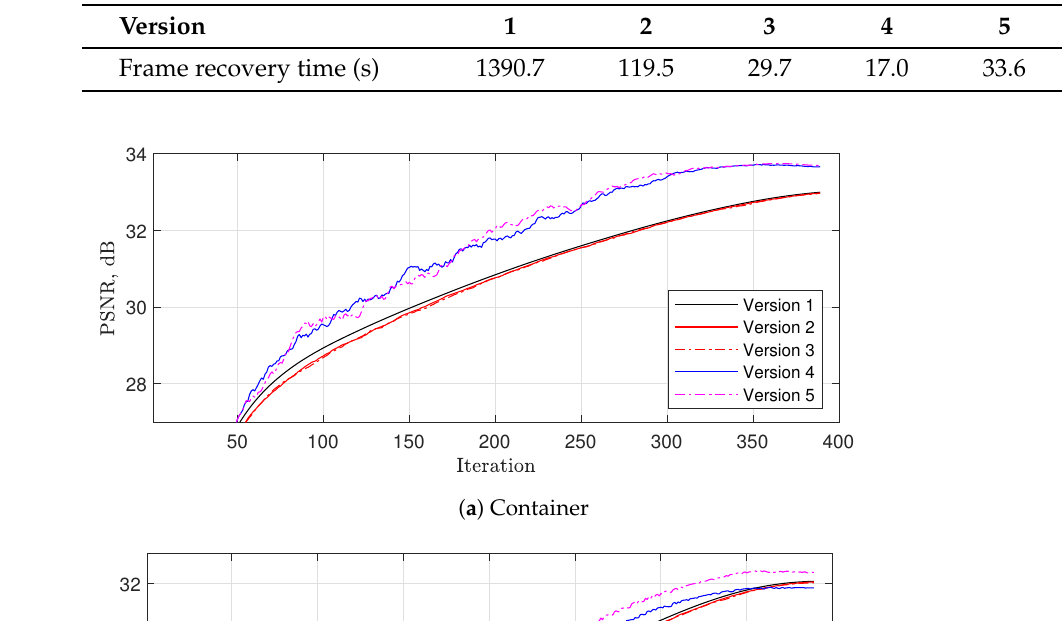
Table 2. Recovery time for frame of size 352 × 288 for thresholding with 16 × 16 × 16 DCT on 2.8 GHz CPU.